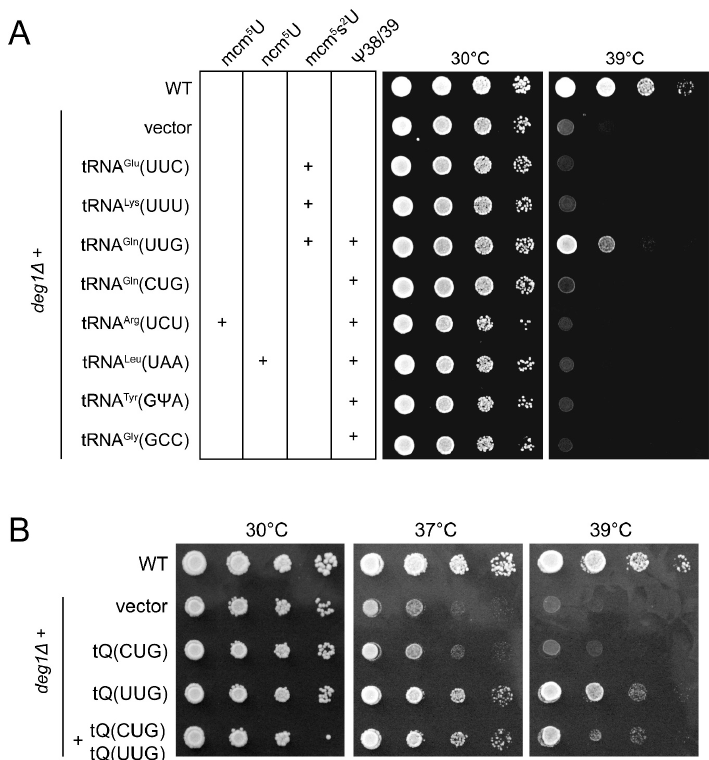
Figure 1. Rescue of deg1 growth defect by tRNA overexpression. ( A ) Single tRNA overexpression. Indicated tRNA species were expressed from multicopy plasmids and in deg1 mutants and serial dilutions spotted on yeast peptone dextrose (YPD) plates that were incubated at 30 °C or 39 °C. In wild type cells, some tRNA species selected for overexpression carry 5 ‐ methoxy ‐ carbonylmethyl ‐ 2 ‐ thiouridine (mcm 5 s 2 U), 5 ‐ carbamoylmethyluridine (ncm 5 U), 5 ‐ methoxy ‐ carbonylmethlyuridine (mcm 5 U), pseudouridine ( ψ ) 38/39 or combinations thereof, as indicated by (+); ( B ) Combined overexpression of tRNA GlnUUG and tRNA GlnCUG . Cells carrying either a multicopy construct for overexpression of tRNA GlnUUG (tQ(UUG)), tRNA GlnCUG (tQ(CUG)) or both were assayed as in ( A ) for growth at 30, 37 and 39 °C. WT: wild type.